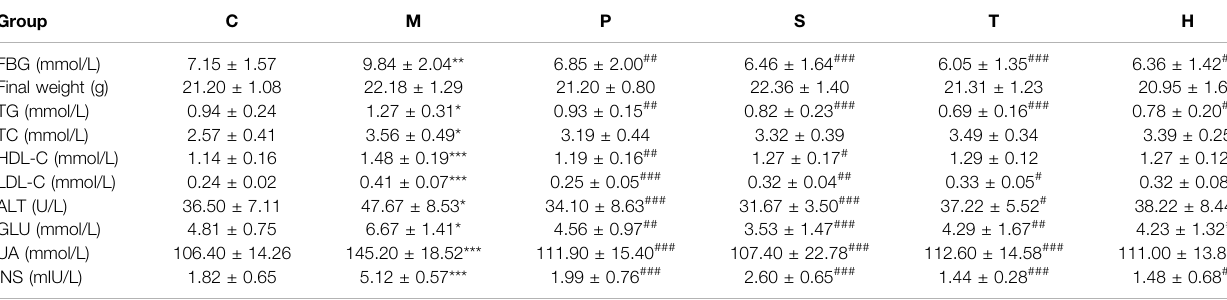
TABLE 1 | Body weight, fasting blood glucose, and serum metabolic parameters in mice. Group